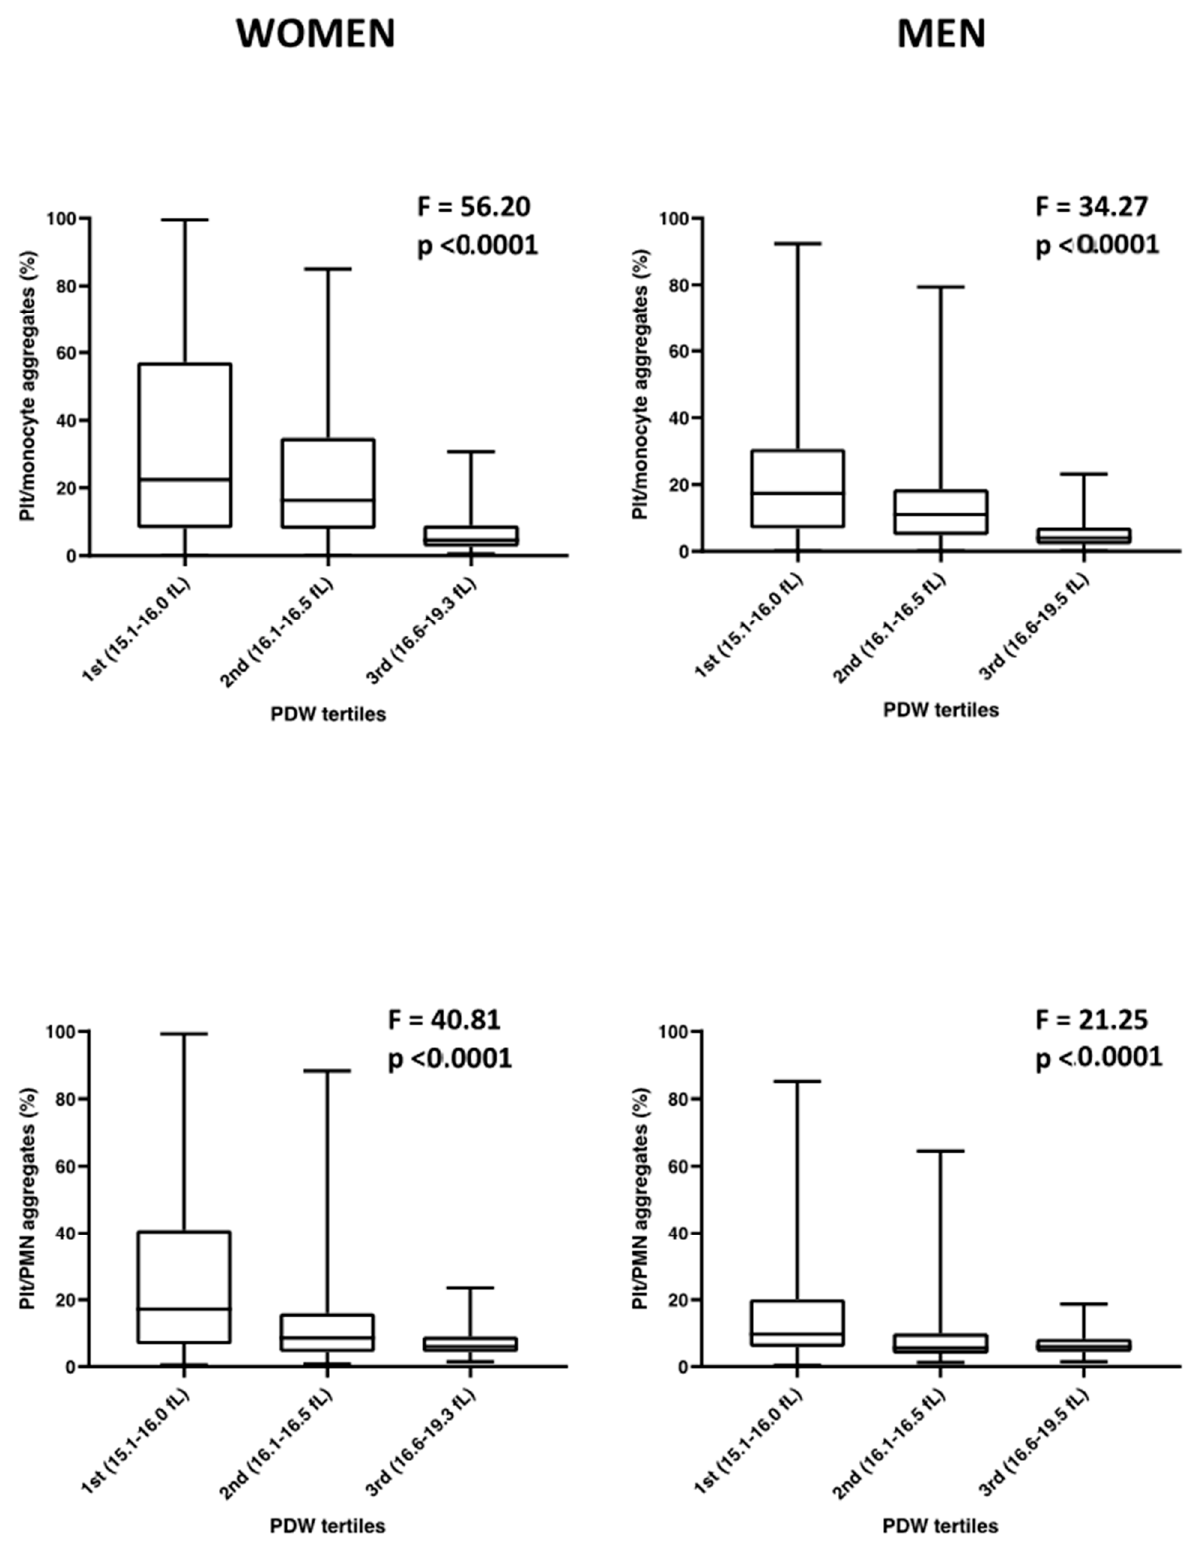
Figure 1. Sex-specific platelet/leukocyte mixed aggregate formation after ADP/collagen stimulation of whole blood, subdivided according to platelet PDW tertiles. Distribution of platelet/monocyte and platelet/PMN mixed aggregates in women and men of the Moli-family cohort over PDW tertiles, as defined by the ranges indicated in parenthesis on the X axis. One-way ANOVA test significance is reported for each graph . N (Women) = 402; N (Men) = 325.